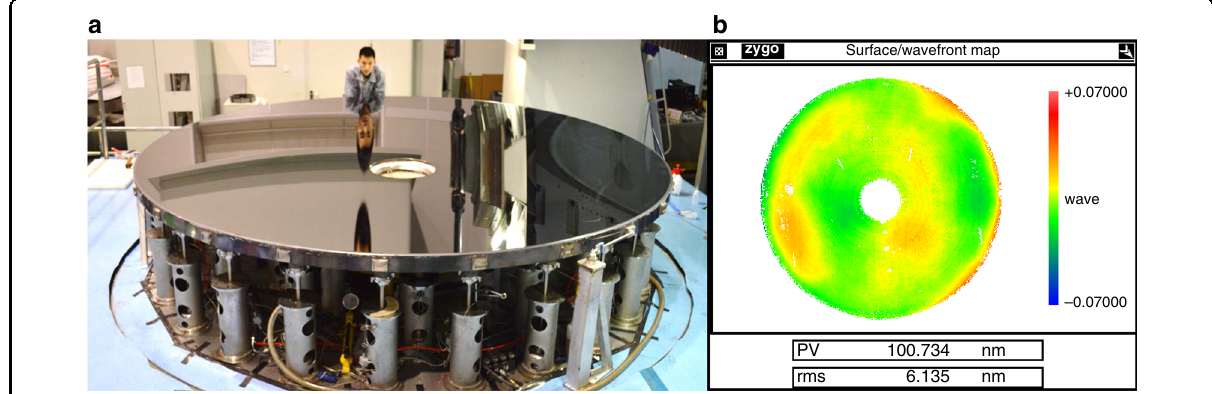
Fig. 15 ⌀ 4.03 m SiC mirror gravity unloading system and surface error change after installation. a Image of the hydrostatic support system 40 . b Changes in the mirror shape after installation